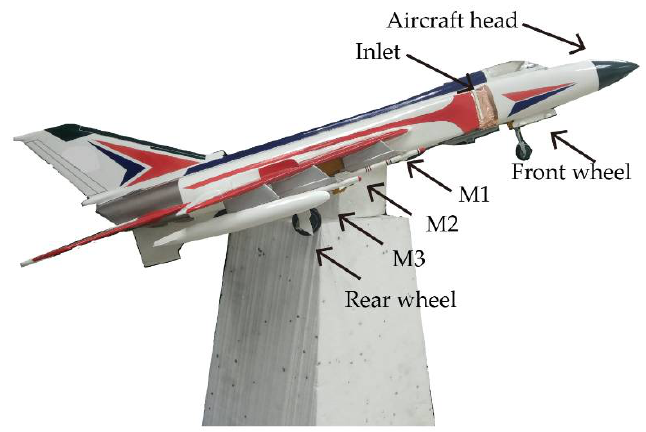
Figure 8. Aircraft model.